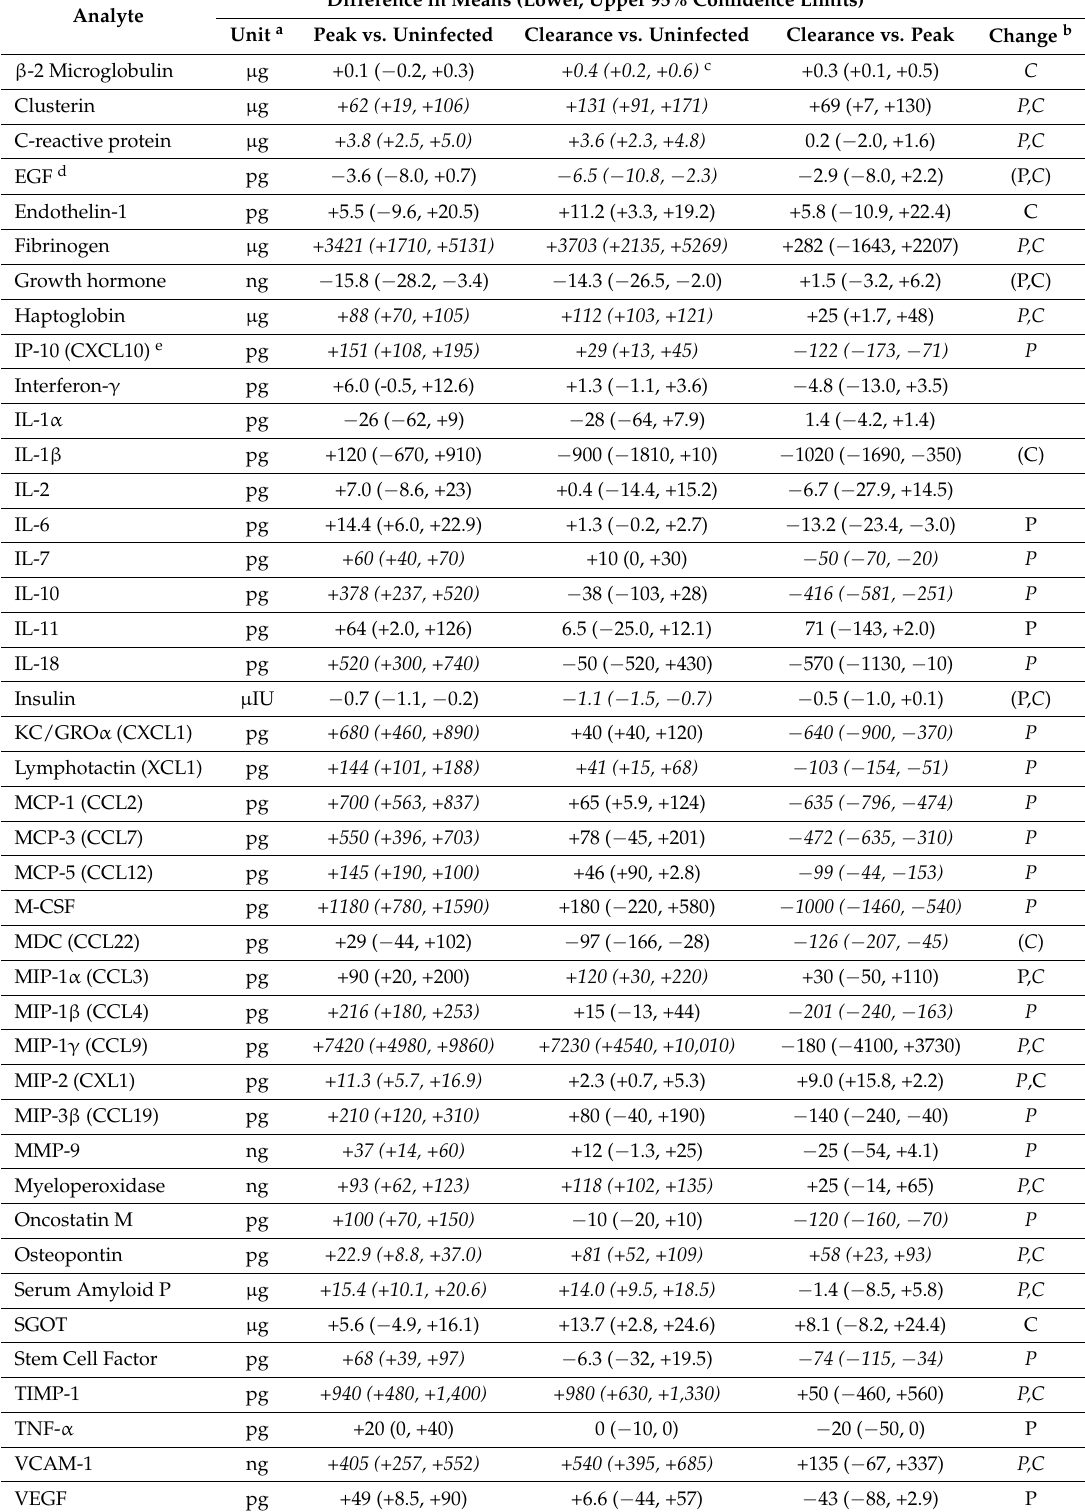
Table 1. Changes in selected proteins in blood of BALB/c mice during course of experimental relapsing